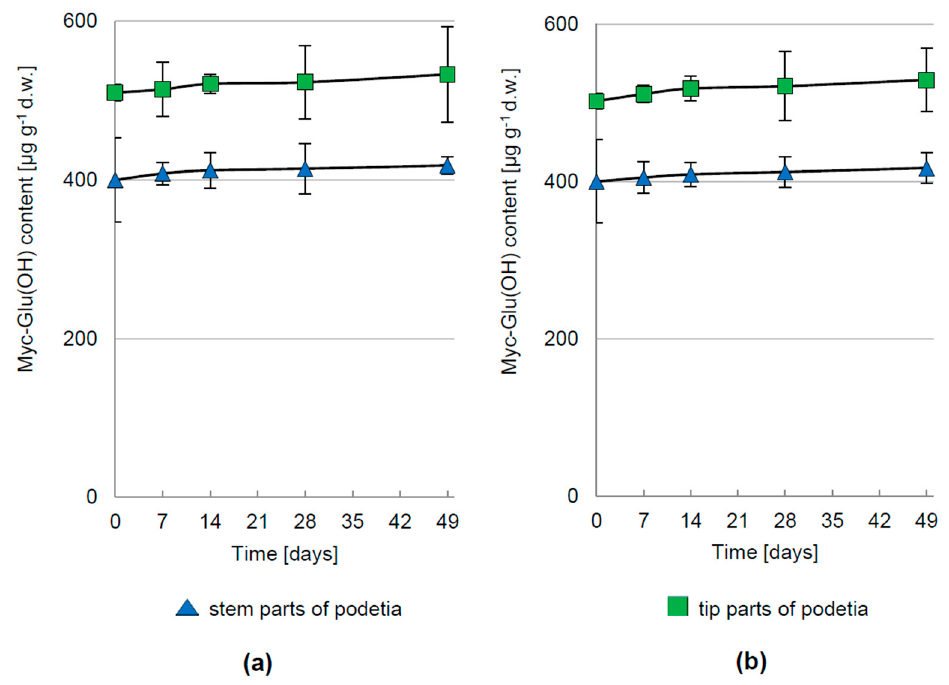
Figure 5. The concentration of Myc-Glu(OH) in C. arbuscula thalli under conditions of CO 2 depriva- tion in the ambient atmosphere with simultaneous exposure to: ( a ) PAR at intensity of 1000 µmol m − 2 s − 1 ; ( b ) darkness; n = 5 ± S.D.; * p < 0.05, d.w.—dry